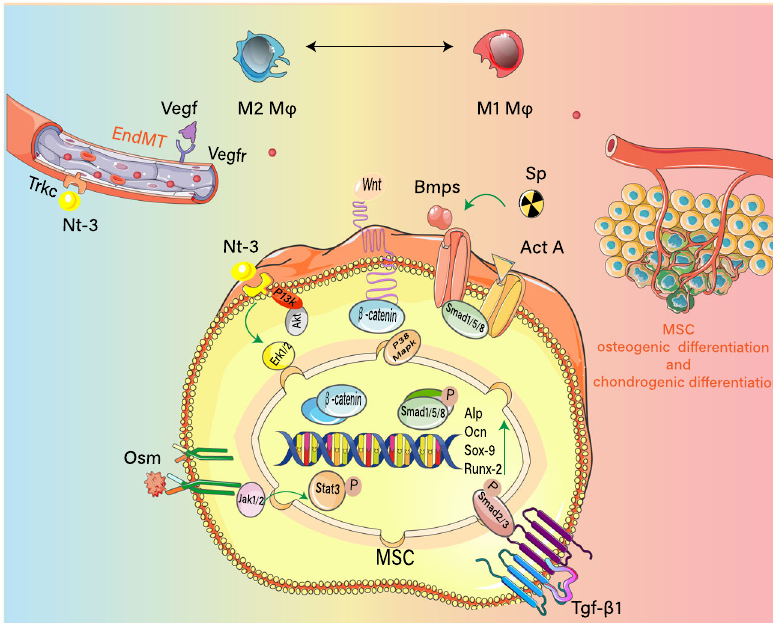
Fig. 2 Molecular mechanisms of HO induced by different phenotypes macrophages. Mononuclear macrophages are polarized to the M1- M2 macrophages in injured tissues in responding to injury. Macrophages secrete OSM and TGF- β 1, BMPs, Act A, SP, and VEGF, and promote the expression of NT-3 and other factors. These signal molecules through different signal pathways, including TGF- β 1-Smad2/3 and BMP- Smad1/5/8, jointly induce osteogenesis of MSCs, angiogenesis, and proper microenvironment formation, promoting the occurrence and development of HO through multiple